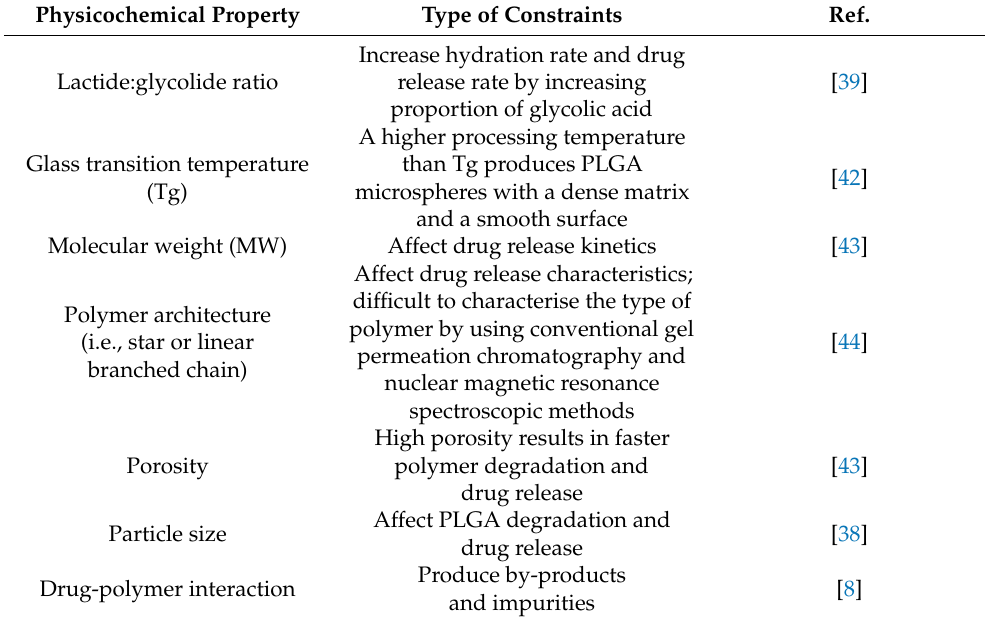
Table 2. Types of constraints related to the physicochemical properties of PLGA during its formulation and the development of long-acting drug